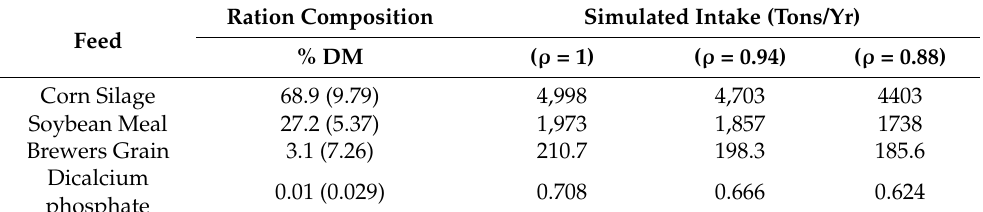
Table 4. Expected average and SD of ration composition and total feed intake from a 1000-cow, 365-day RuFaS simulation with 3 levels of feed efficiency: baseline ( ρ = 1), high ( ρ = 0.94), and very high ( ρ = 0.88).